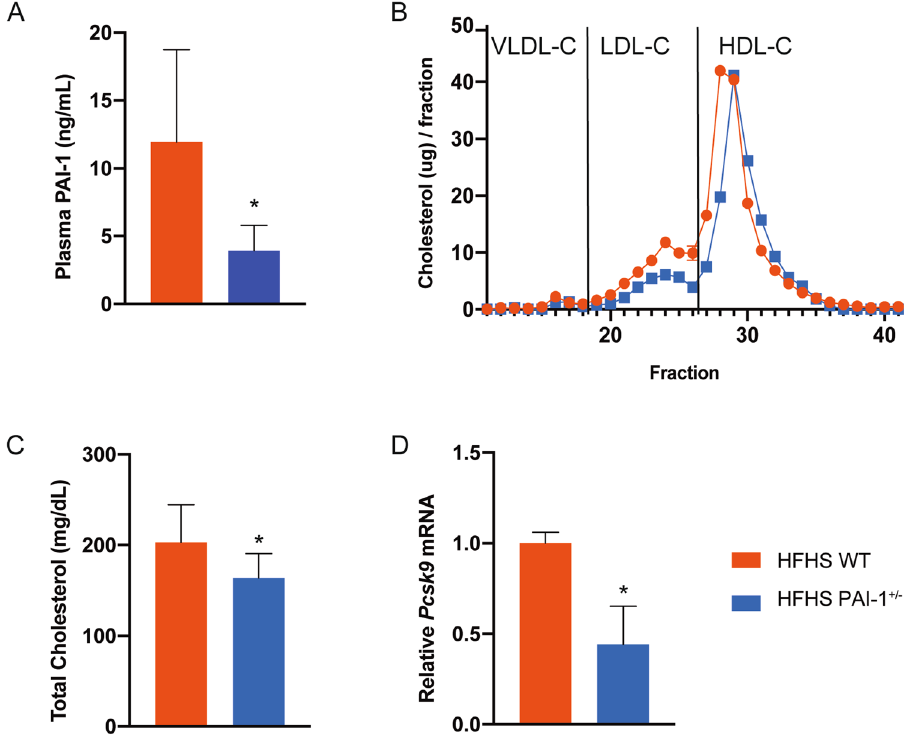
Figure 4. PAI-1 heterozygosity is associated with lower Pcsk9 and cholesterol profiles in HFHS fed mice. 20 week-old wild-type or Pai-1 +/− C57BL/6 J male mice fed HFHS diet. At the endpoint murine hepatic mRNA and plasma were analyzed. ( A ) Plasma PAI-1 levels. ( B ) Cholesterol content profile of the lipoprotein fractions resolved by FPLC from pooled samples (n = 6 for WT, n = 7 for Pai-1 +/− ). ( C ) Plasma total cholesterol. ( D ) Hepatic PCSK9 mRNA expression normalized to GAPDH. Values are expressed as mean ± SEM (n = 6–7), * p <